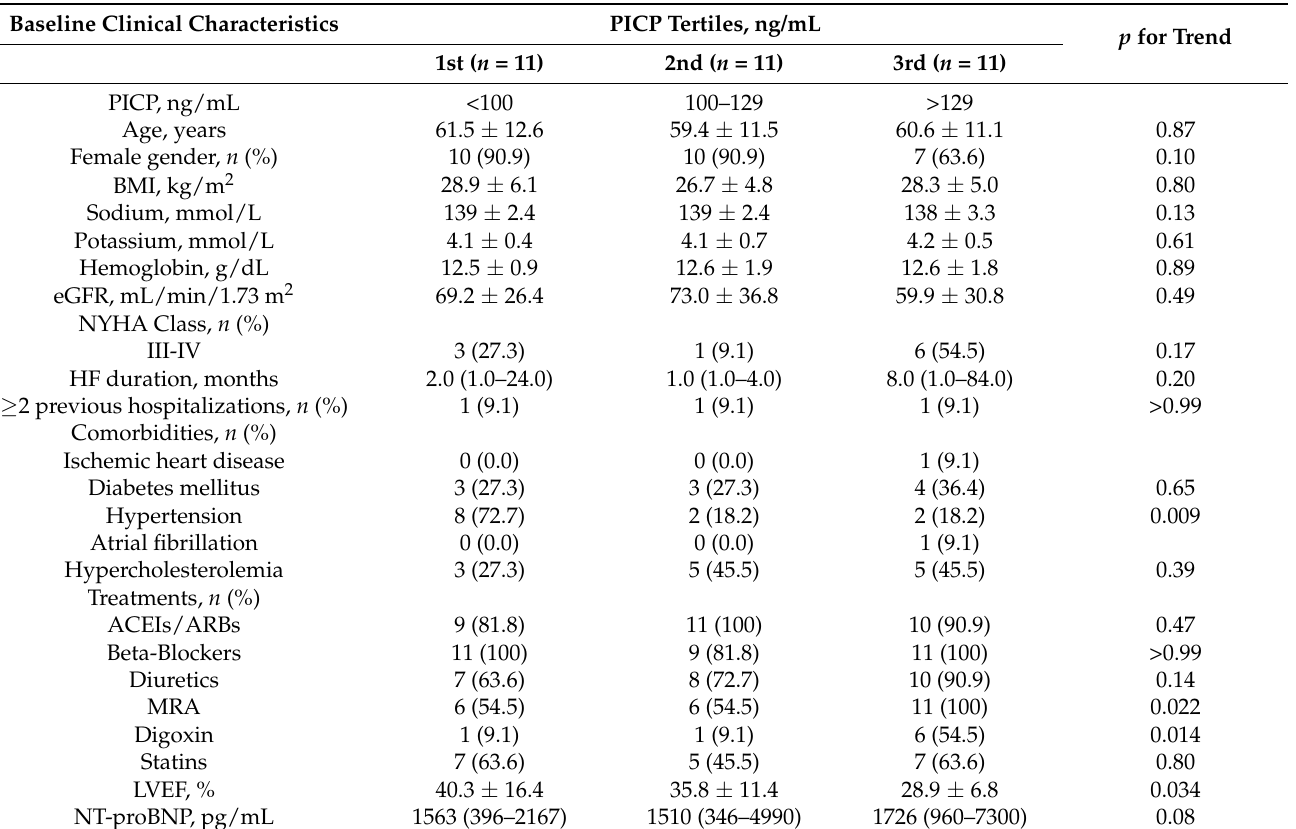
Table 7. Baseline clinical characteristics of ACC-HF patients with echocardiography at 1-year follow- up classified according to PICP tertiles.